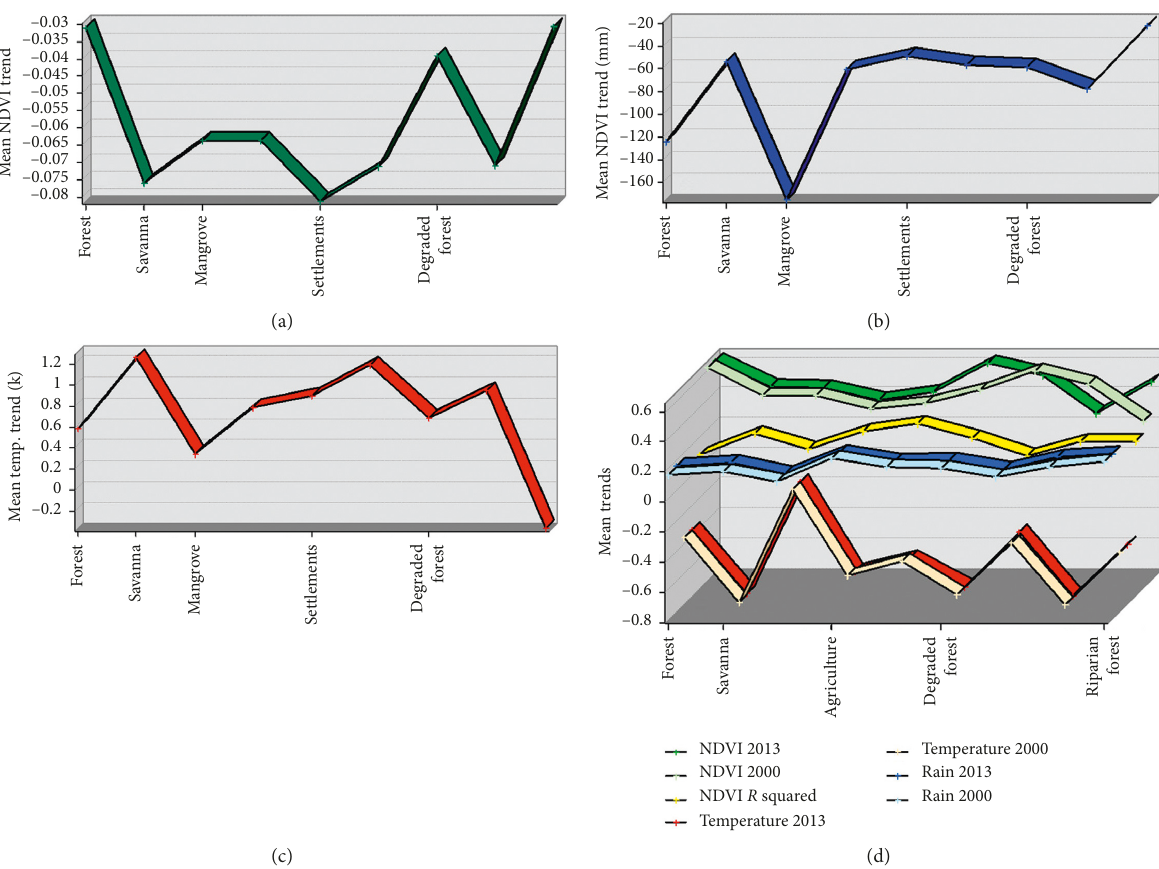
Figure 8: Spatial trend patterns across landcover types in the study area from 2001 to 2017: (a) mean NDVI; (b) precipitation; (c) temperature; (d) combination of all